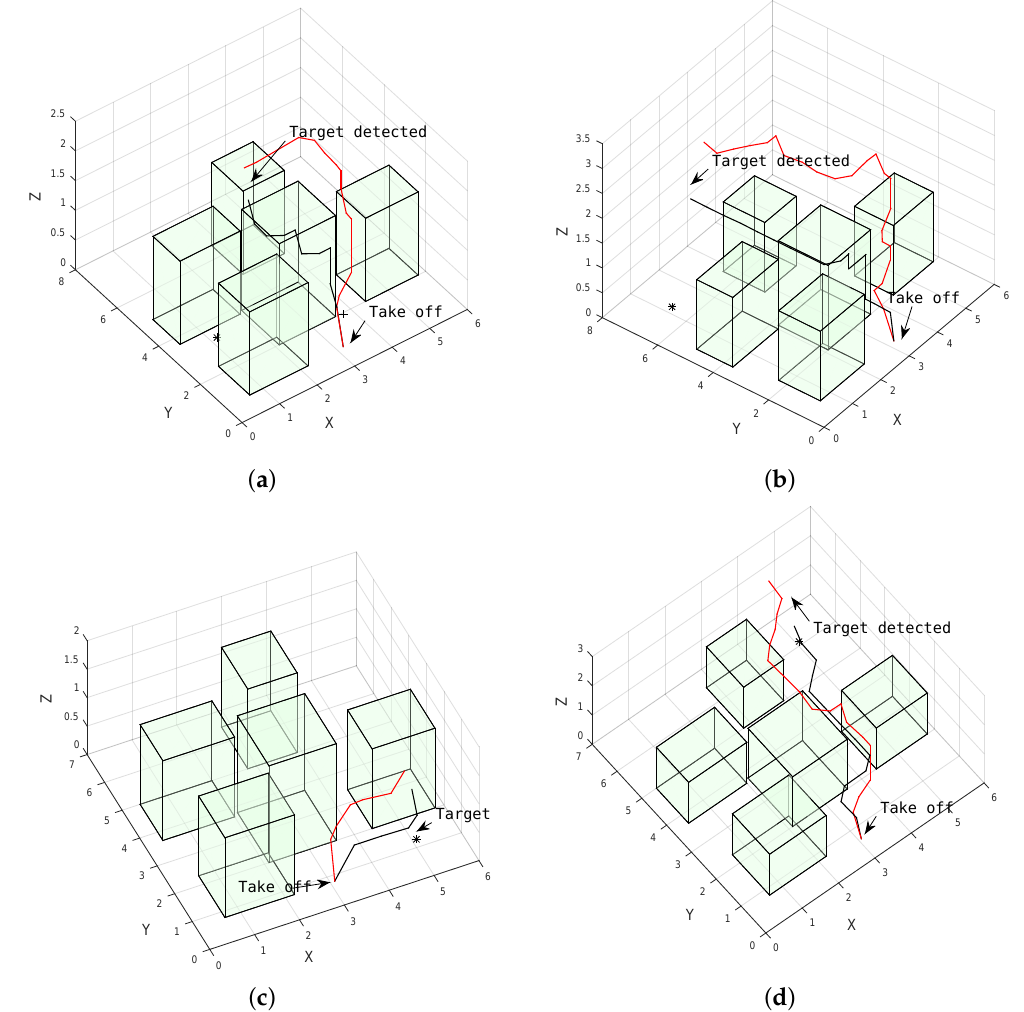
Figure 6. Example of trajectories to four different target locations produced by ABT (black), and POMCP (red) in simulation. ( a ) Target located at (1.0, 3.0, 0.15); ( b ) target located at (1.0, 6.5, 0.15); ( c ) target located at (5.0, 1.0, 0.15); ( d ) target located at (5.0, 6.0,